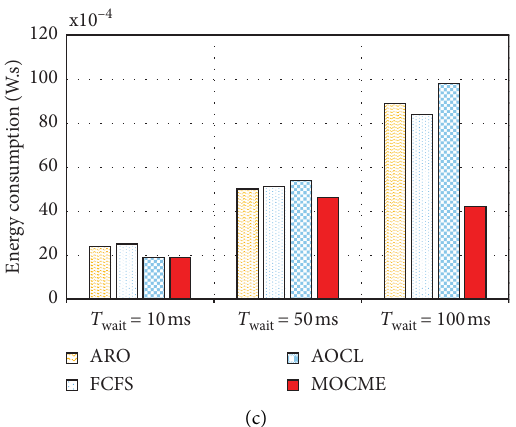
Figure 7: Average energy consumption of MDs. (a) Number of WAs � 4. (b) Number of WAs � 5. (c) Number of WAs � 6. 00.20.40.60.811.2